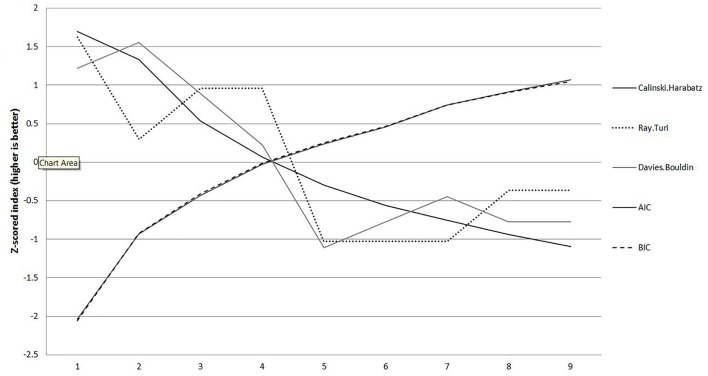
Fit indices for different profile solutions. Horizontal bar indicates four profile cut-off.